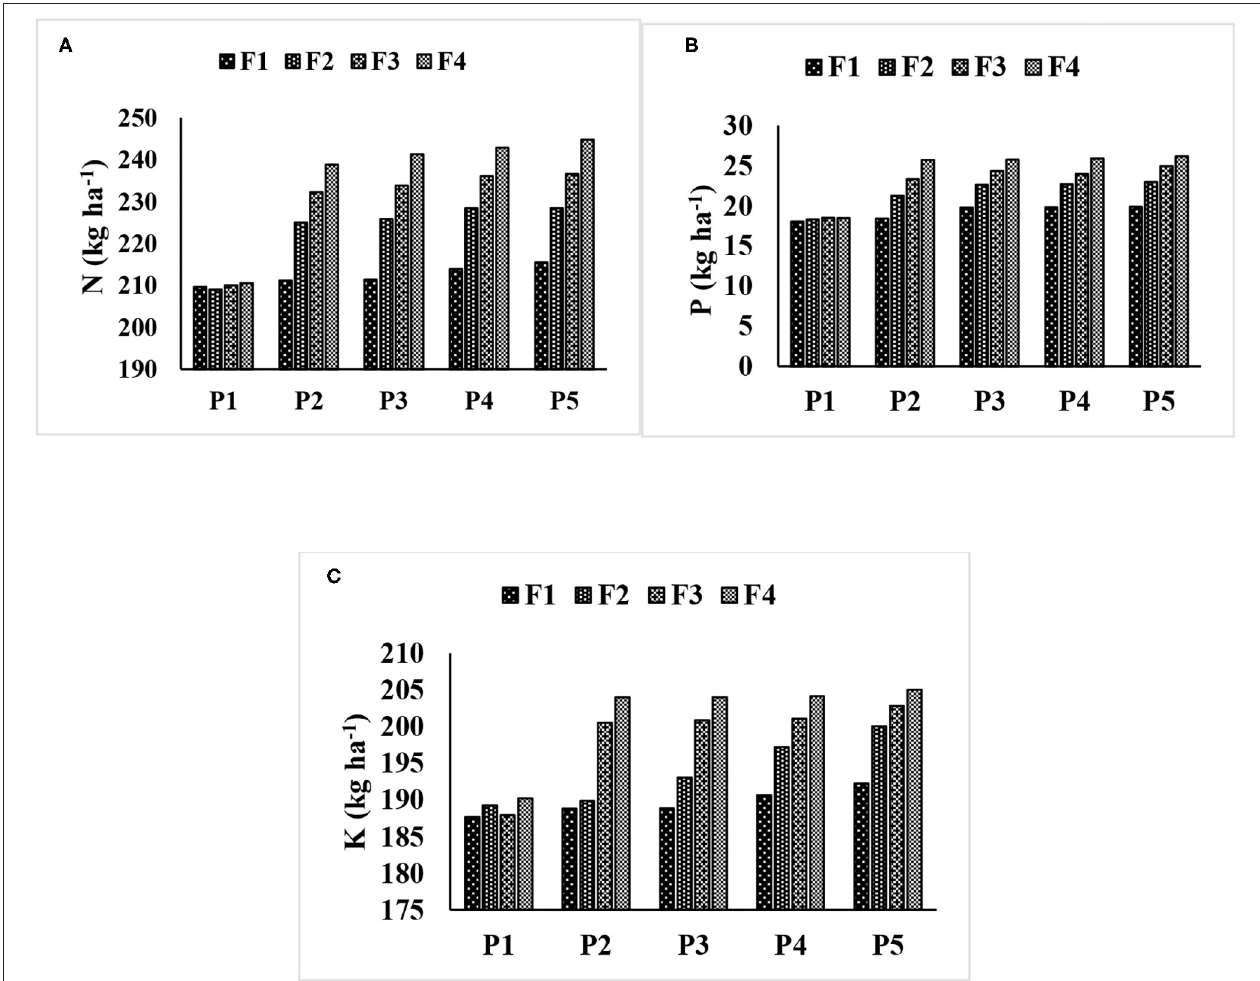
FIGURE 2 | Interaction of fertilizer dose and time and rate of panchagavya application on available nitrogen (A) , phosphorus (B) , and potassium (C) in the soil after harvest of hybrid rice under SRI. F 1 , F 2 , F 3 and F 4 are the 60, 80, 100 and 120% RDF respectively, D 0 -Control; D 1 -3% foliar sprays at 15, 30 and 45 DAT; D 2 - seedling root dip + 3% foliar spray at 30 DAT + application with irrigation water at 60 DAT; D 3 -6% foliar sprays at 15, 30 and 45 DAT; D 4 - seedling root dip + 6% foliar spray at 30 DAT + application with irrigation water at 60 DAT